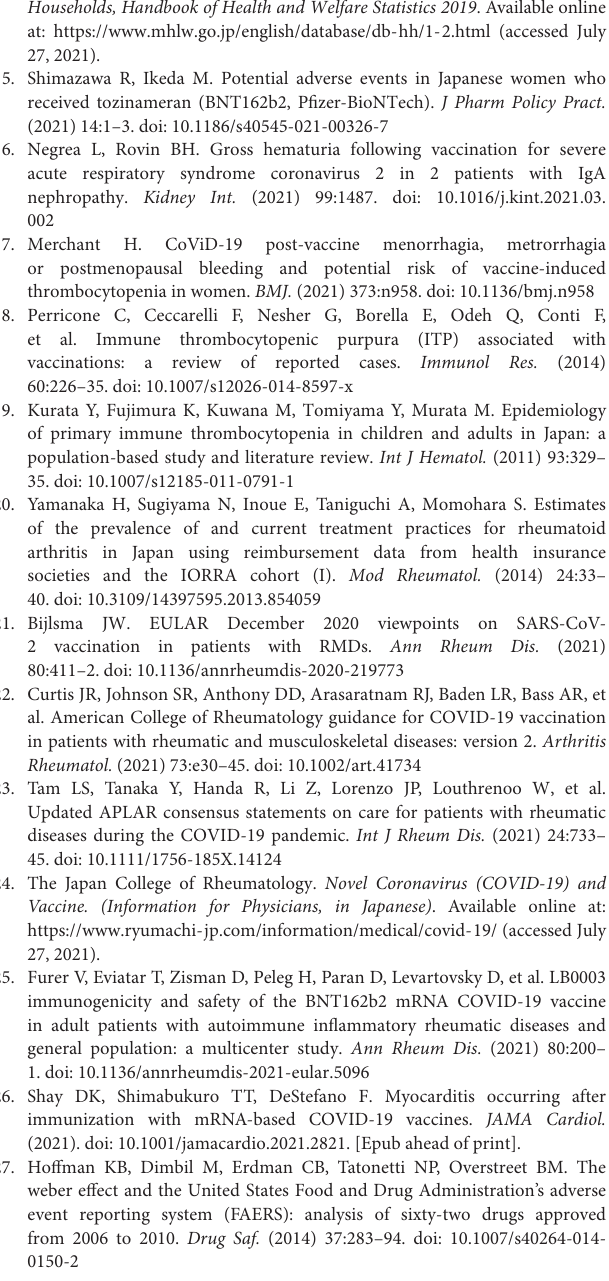
Supplementary Figure 2 | Analysis of Supplementary Table 1 . Patients with thrombocytopenia after BNT162b2 vaccine administration. Population analysis of age, sex, distribution of platelet counts, and onset of thrombocytopenia (days after vaccination). Supplementary Table 1 | Patients with thrombocytopenia after BNT162b2 vaccine